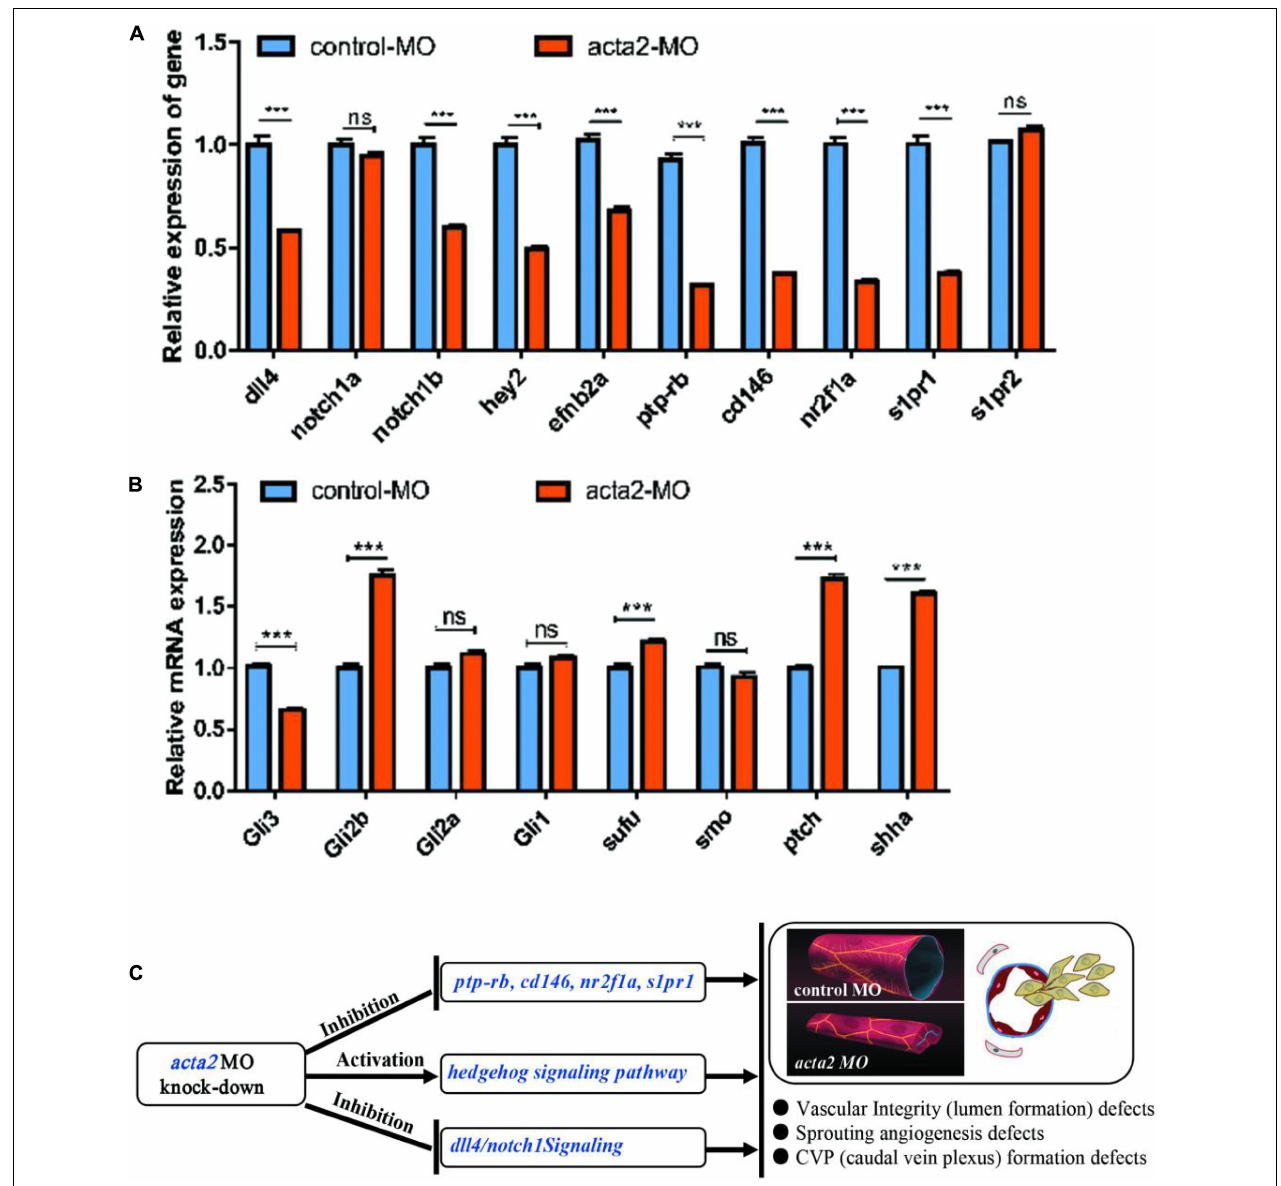
FIGURE 9 | (A) Endogenous dll4, notch1a, notch1b, hey2, efnb2a, ptp-rb, cd146, nr2f1a, s1pr1 and s1pr2 in control and acta2 morphants assessed by qRT-PCR ( n = 6–10 individual embryos). *** P < 0.001; ns, not significant. (B) Endogenous shha, ptch2, smo, Sufu, Gli1, Gli2a, Gli2b, and Gli3 in control and acta2